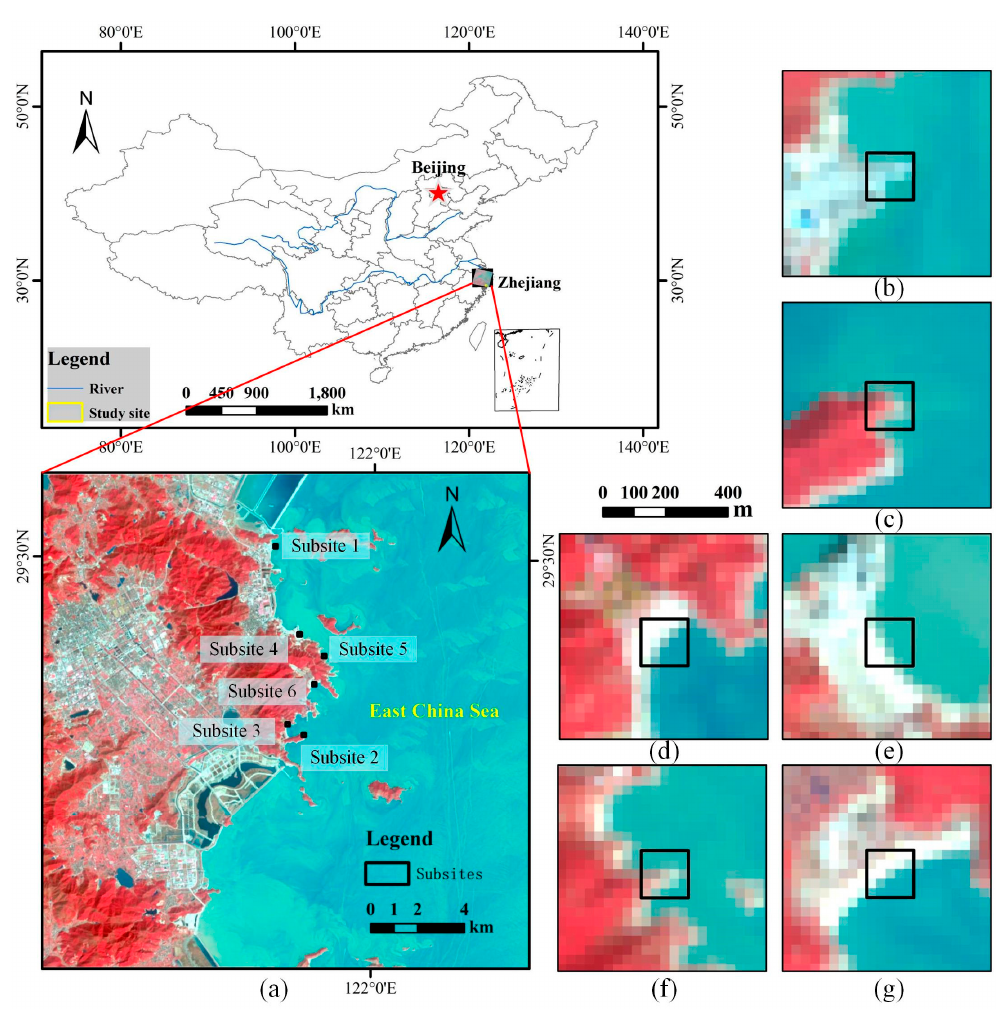
Figure 1. Geographical location of study area and the Landsat-8 OLI imagery: ( a ) multispectral (MS) image (R: band 5, G: band 4, B: band 3); ( b – g ) subsites 1–6 in turn.